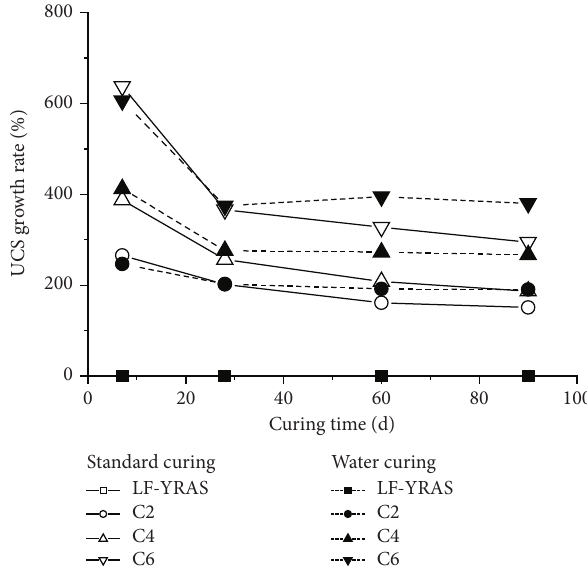
Figure 4: UCS growth rates of LF-YRAS, C2, C4, and C6 after curing for 7 d, 28d, 60d, and 90d.